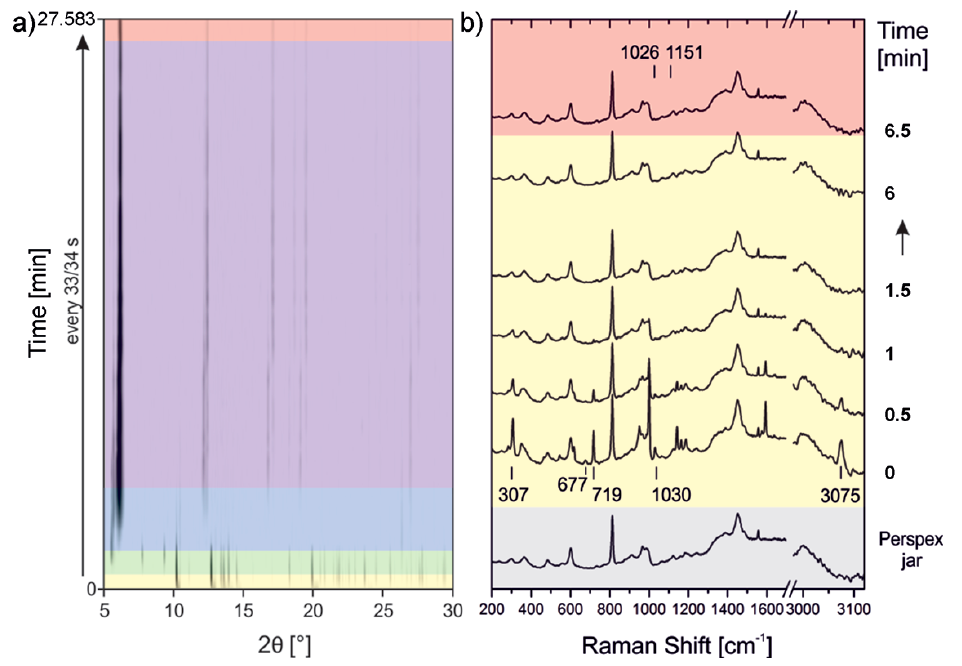
Figure 20. Synthesis process of Co(PhPO 3 )·H 2 O followed in situ by ( a ) synchrotron X-ray diffraction (XRD) and ( b ) Raman spectroscopy. The first measurement of the Raman plot (grey) is the Raman spectrum of the empty Perspex jar, indicating the modes arising from the sample holder. Colour code: yellow: reactants, green: reactants and intermediate phases, blue: reactants, intermediate phases and product, purple: intermediate phases and product, red: product. Adapted with permission from reference [97]. Copyright 2015, Wiley-VCH Verlag GmbH and Co.